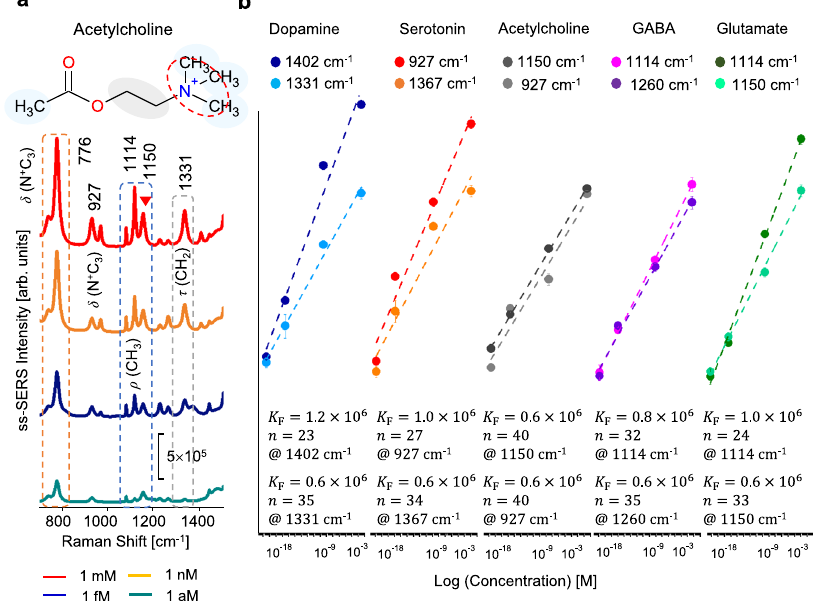
Fig. 4 LODs and ss-SERS spectra of primary neurotransmitters for different concentrations ranging from 1 mM (10 -3 M) to 1 aM (10 − 18 M). a The characteristic Raman peak intensities of ss-SERS for acetylcholine of the learning neurotransmitter associated with Alzheimer ’ s dementia depending on neurotransmitter concentrations. The ss-SERS spectra exhibit a major SERS peak at 1150 cm − 1 assigned to CH 3 rocking and CH 2 wagging. δ bending, τ twisting, ω wagging, ν stretching, ρ rocking. (The output power of the laser: 25 mW, the power at the sample: 1 mW, accumulation time: 10 s.) b Limit of detection for primary neurotransmitters down to attomolar concentrations. The nonlinear fi t curves based on the experimental data for the (cid:1) (cid:3) neurotransmitters agree well with the Freundlich isotherm-like behavior log q e ¼ log K F þ 1 n log C e , where q e , K F , n , and C e represent the ss-SERS peak intensity, Freundlich isotherm constant, Freundlich isotherm exponent, and concentration,